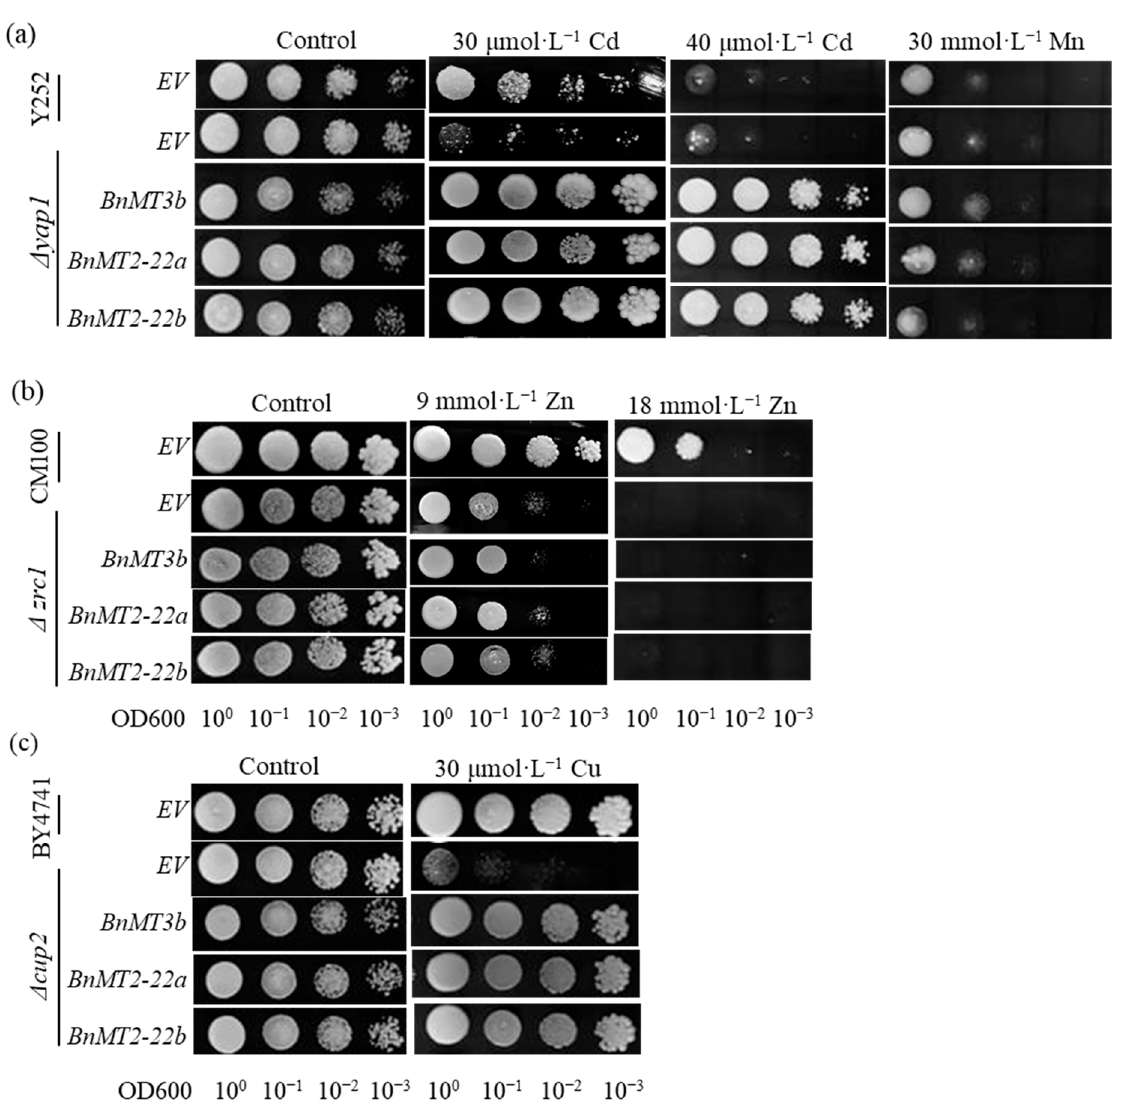
Figure 3. Expression of BnMT s enhanced Cd and Cu tolerance in yeast. ( a – c ) BnMT3b , BnMT2-22a , BnMT2-22b were transformed into Cd-sensitive yeast mutant ∆ yap1 , Zn-sensitive yeast mutant ∆ zrc1 and Cu-sensitive yeast mutant ∆ cup1 , and the yeast transformants were subjected to Cd, Mn ( a ), Zn ( b ) and Cu ( c ) tolerance assays. EV: empty vector.